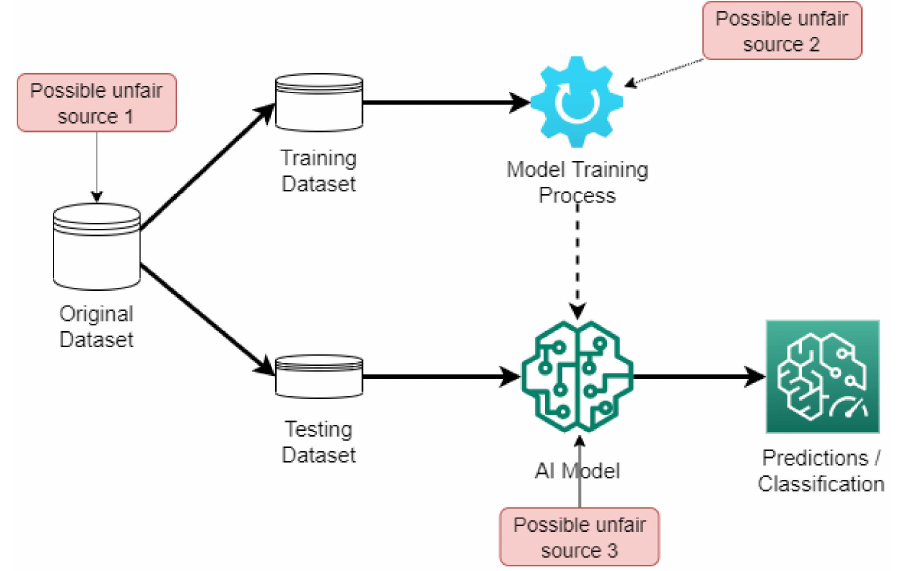
Figure 13. Deep learning workflow and possible sources of